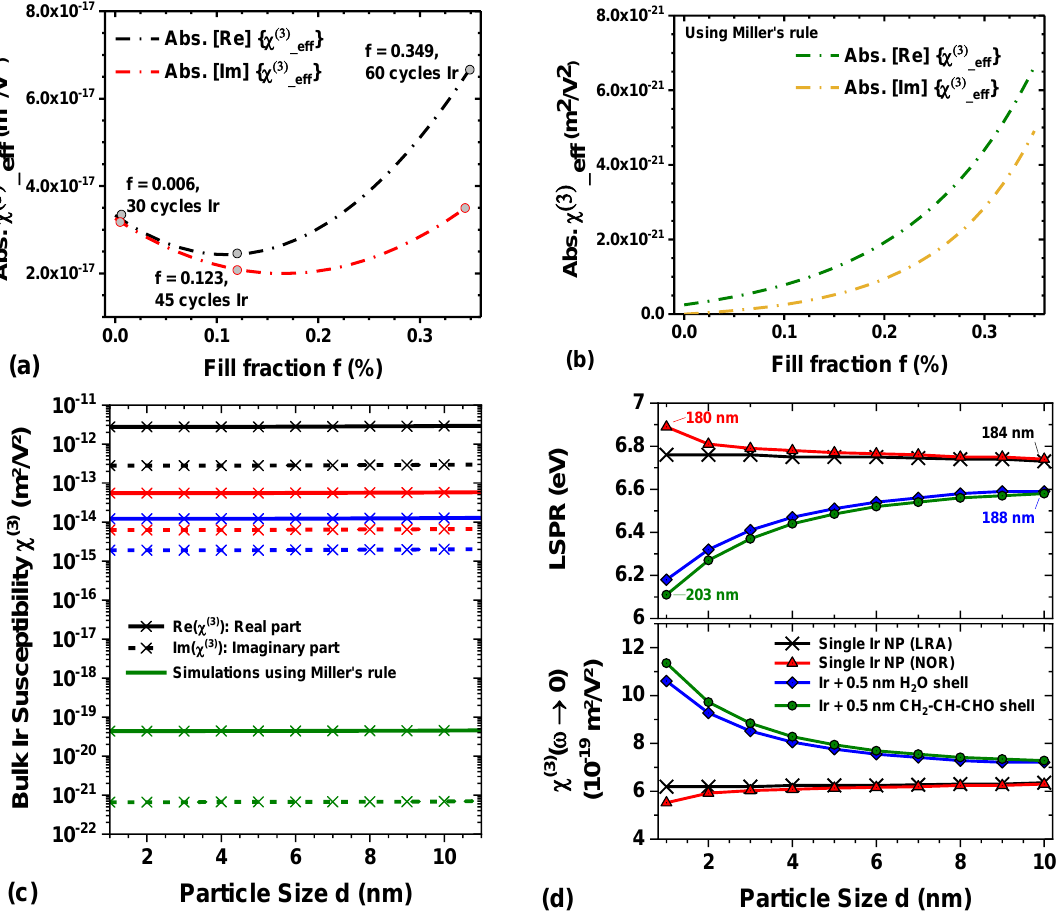
Figure 4. ( a , b ) Real and imaginary parts of the effective susceptibility at the 700 nm fundamental wavelength (FH) for Ir coatings depending on the fill fraction. ( a ) The values with experimentally determined χ (3) and fill fraction values. ( b ) Values derived from Miller’s rule. ( c ) Bulk Ir susceptibility; the real (solid) and imaginary (dashed) parts are shown for data fitted to the three experimental results, yielding three slightly different nonlinear coefficients a = b 𝜔 𝑝8 , with b = (−1.12 − i0.15) × 10 −15 m 2 /V 2 blue curves), b = (−5.08 − i0.46) × 10 −15 m 2 /V 2 (red curves), b = (−2.55 − i0.2) × 10 −13 m 2 /V 2 (black curves), and the result according to Miller’s rule (green curves). ( d ) Shift of the localized surface plasmon resonance (LSPR, top panel) and Ir susceptibility according to Miller’s rule (bottom panel) affected by an ultrathin shell of water (blue) and CH2-CH-CHO (green) surrounding the Ir nanoparticles in air. In addition, we compared single Ir NP in the classical local response approximation (LRA, black curves) and the size-induced quantum shift from the nonlocal optical response (NOR, red curves).